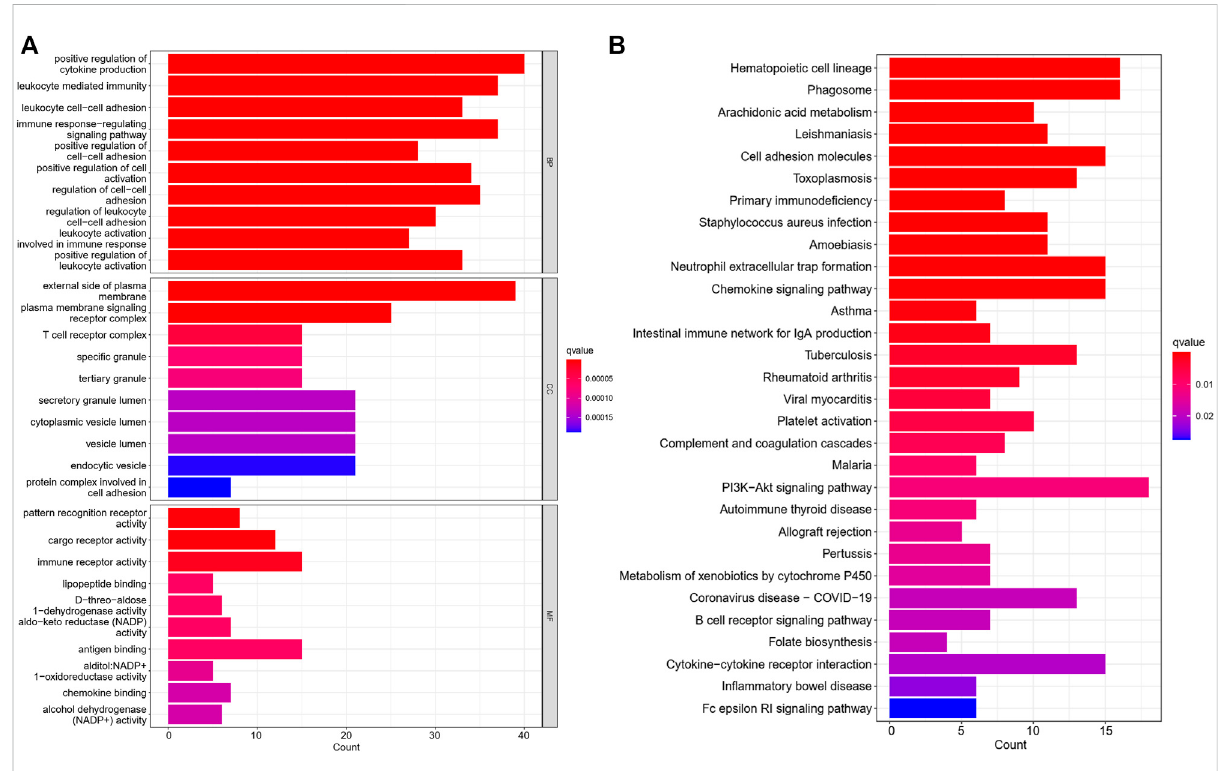
FIGURE 5 The GO and KEGG analyses between the two risk groups (A) Bar graph for GO enrichment. (B) Bar graph for KEGG pathways (the longer bar means the enrichment of more genes, and the increasing intensity of red color means more obvious differences; q-value: the adjusted p